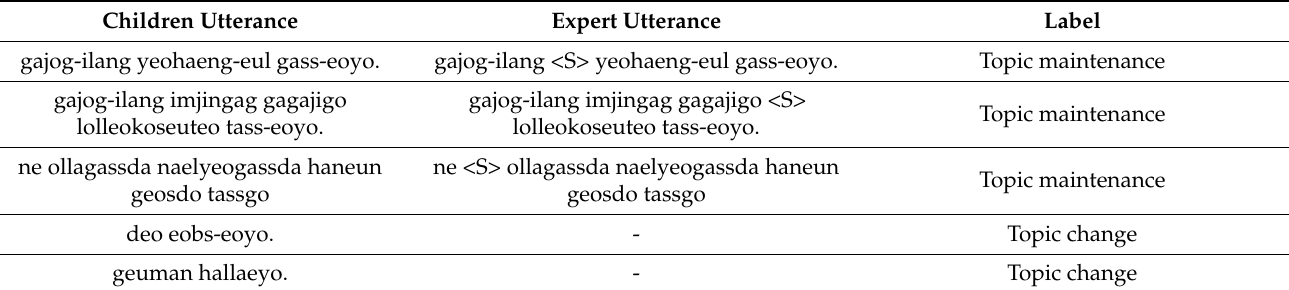
Table 2. Data sample with structured data for training the